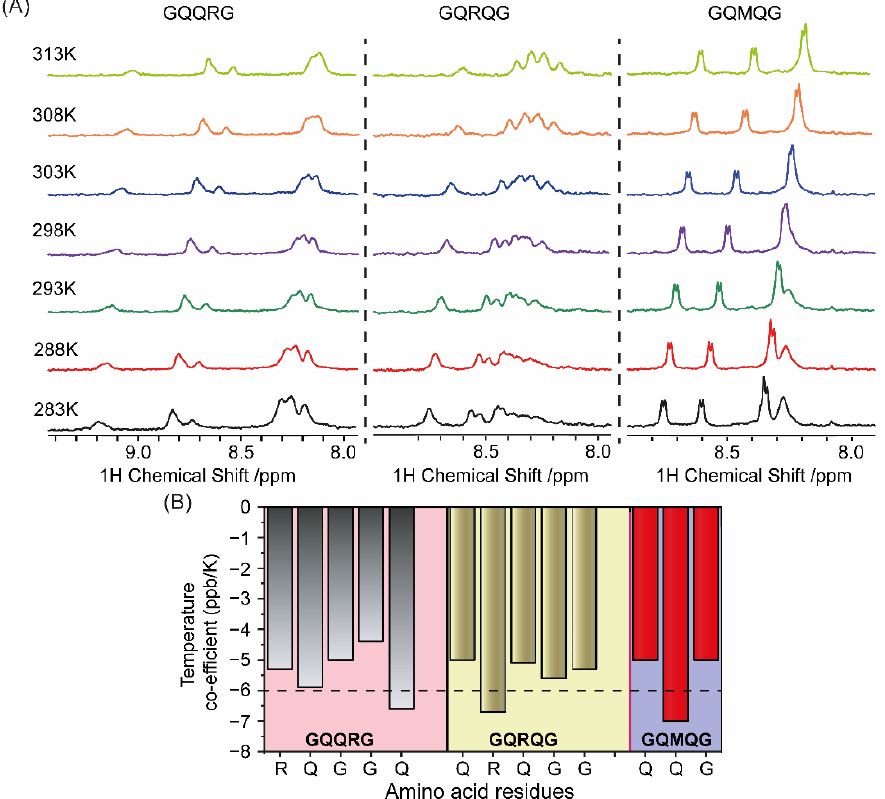
Figure 6. ( A ) Temperature-dependent NMR spectroscopy showing changes in the amide proton chemical shift of GQQRG, GQRQG, and GQMQG at different temperatures in CD3OD. ( B ) Temperature coefficients of the amino acid residues for the respective peptides from 1D 1 H NMR were calculated and plotted as bar diagram ( B ).